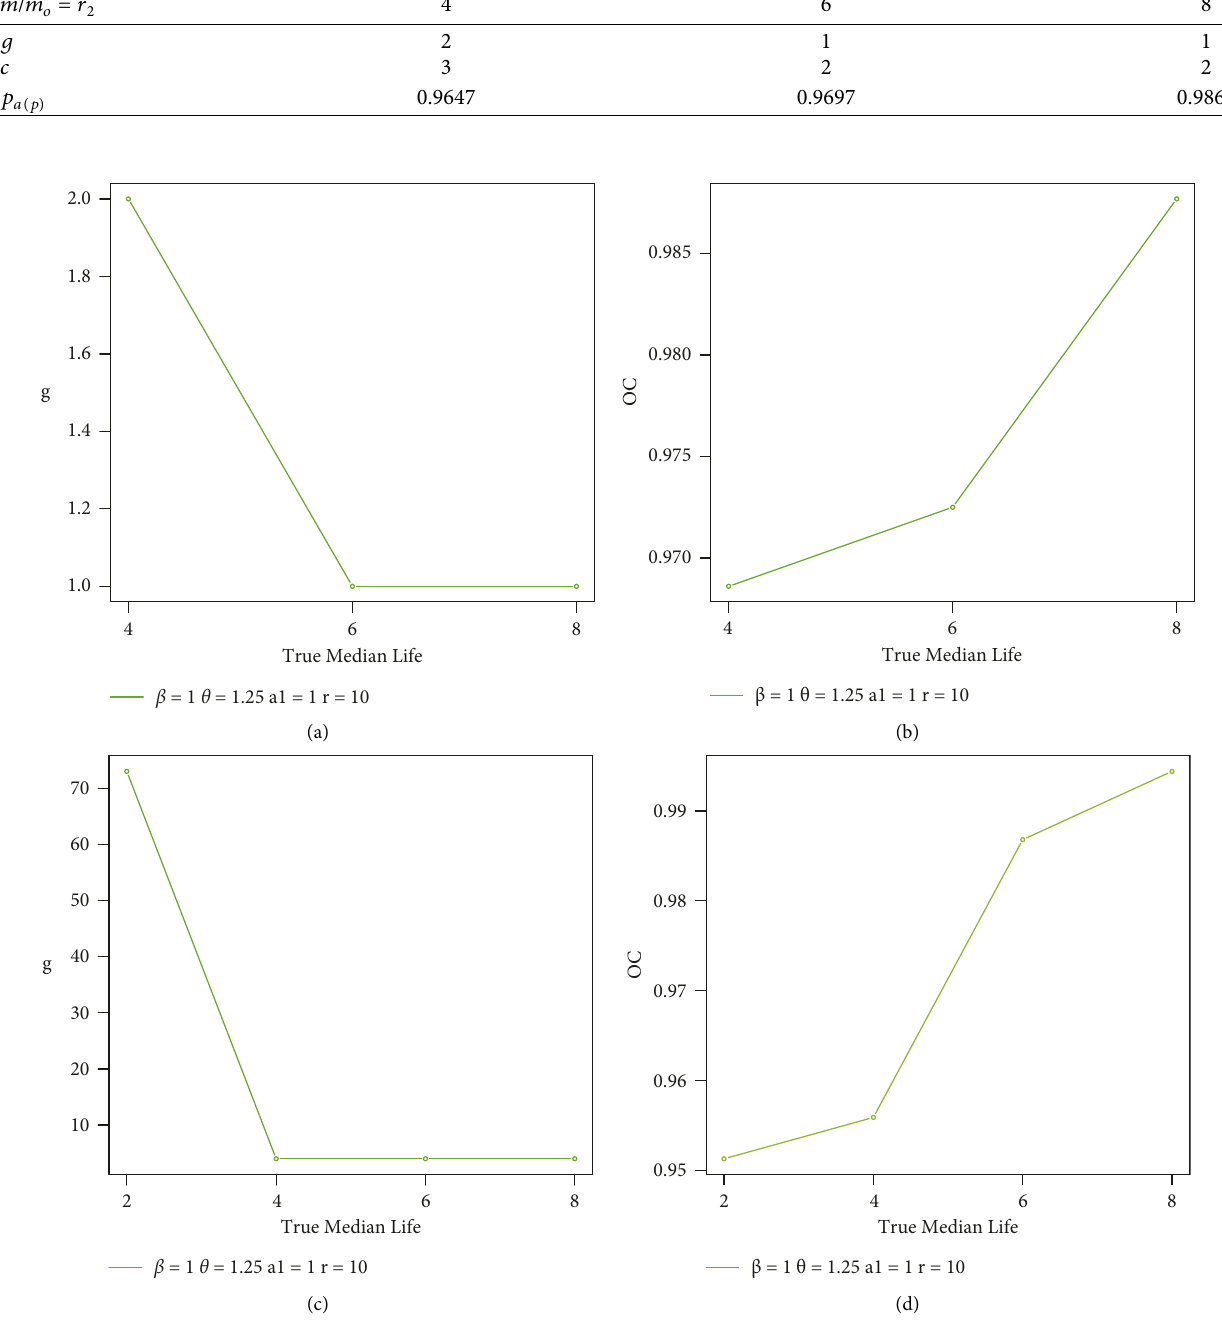
Figure 1: Graphical illustration of g and OC for some parametric values taken from Tables 1 and 2, respectively.